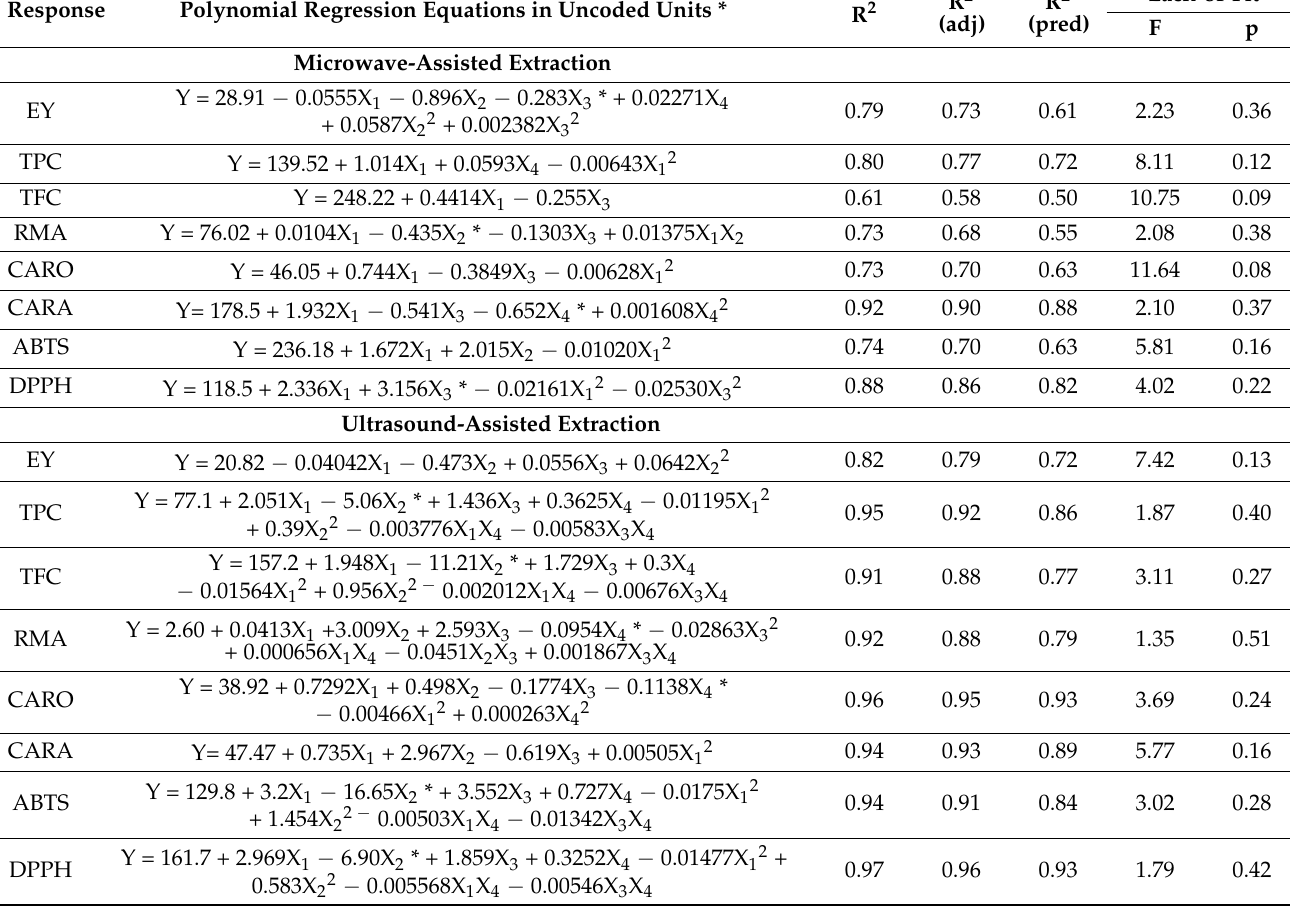
Table 4. Polynomial regression equations for the eight response variables (EY, TPC, TFC, RMA, CARO, CARA, ABTS, and DPPH) of the post-distillation solid residue of sage extract using MAE and